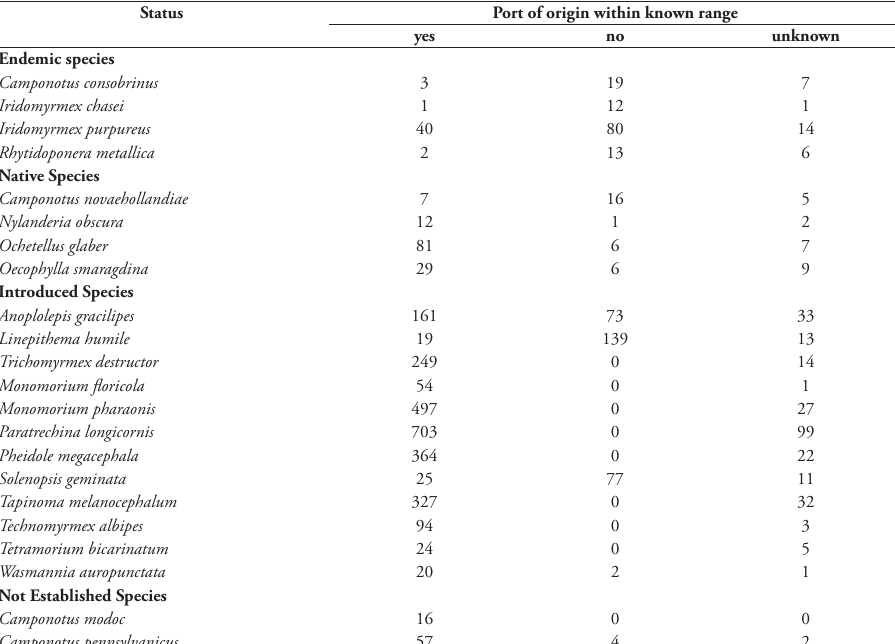
Table 6. The number of records for the most commonly intercepted species separated by status (endemic, native, introduced, or not established) and whether the port of origin for the record was within (“yes”) or outside (“no”) the known range of the